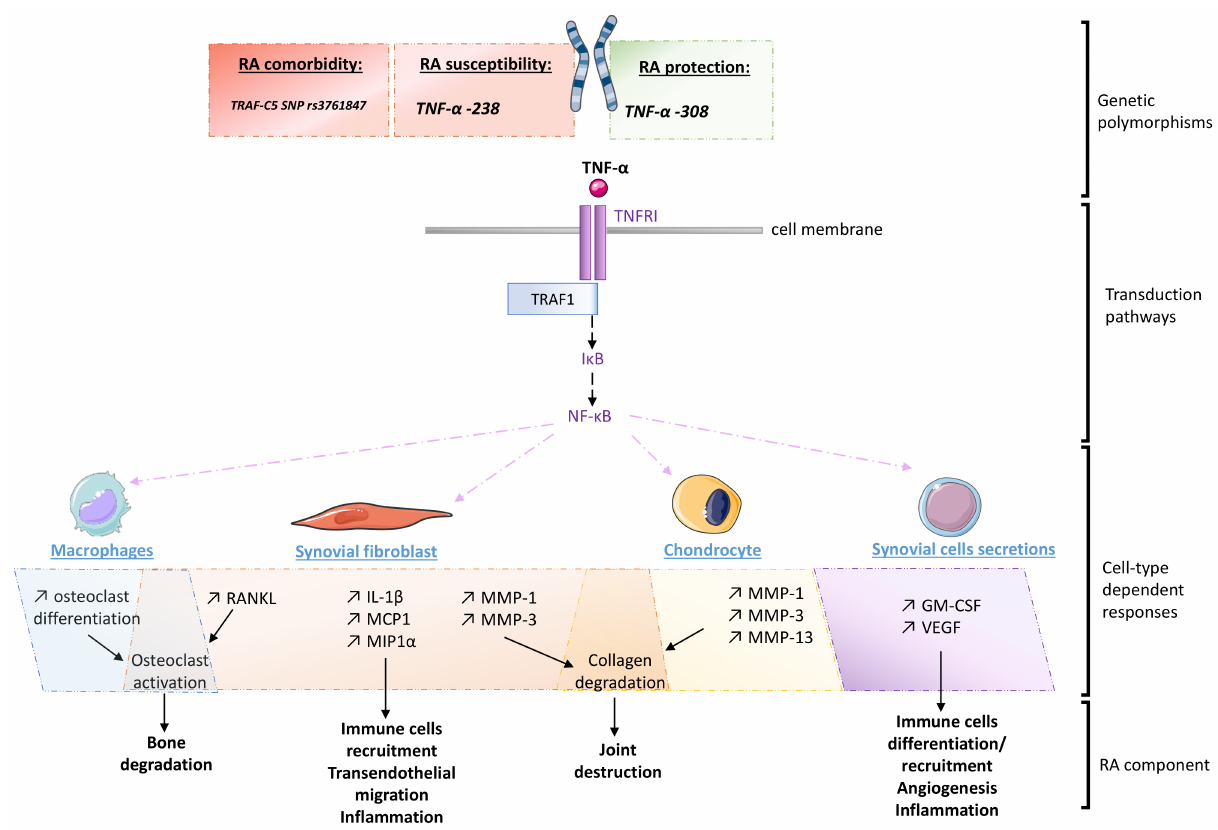
Figure 2. Schematic representation of the different levels of TNF- α ’s implication in the pathogenesis of rheumatoid arthritis (RA): IL-1 β : Interleukin-1 β ; I κ B: Inhibitor of nuclear factor- κ B; GM-CSF: Granulocyte-macrophage colony-stimulating factor; MAPK: Mitogen-activated protein kinase; MCP1: Monocyte chemoattractant protein-1; MIP1 α : Macrophage inflammatory protein-1 alpha; MMP: Matrix metalloproteinase; NF- κ B: Nuclear factor- κ B; RANKL: Receptor activator of nuclear factor- κ B ligand; SNP: Single nucleotide polymorphism; TIR: Toll-IL-1 receptor; TNFRI: TNF receptor type 1; TRAF1: TNF receptor- associated factor; TRAF-C5: TNF receptor-associated factor 1 and complement component 5; VEGF: Vascular endothelial growth